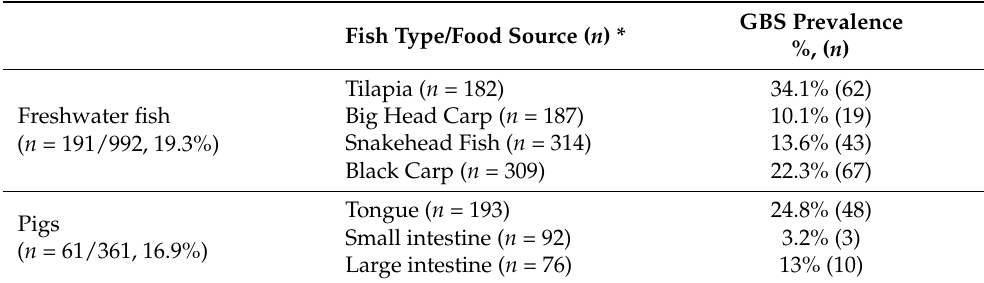
Table 1. Prevalence of GBS in freshwater fish and pig samples procured from wet markets in Hong Kong.